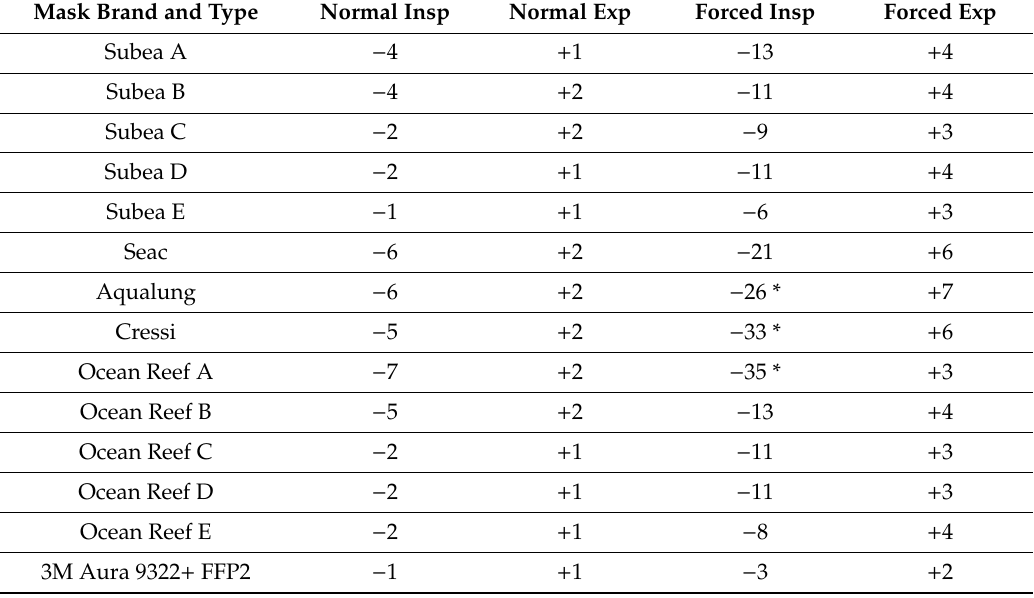
Table 4. Inspiratory (‘Insp’) and expiratory (‘Exp’) pressures (in cmH 2